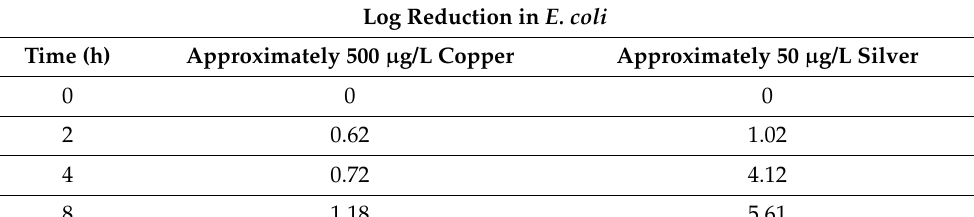
Table 2. Log reduction in E. coli bacteria by electrolytically generated copper and silver.